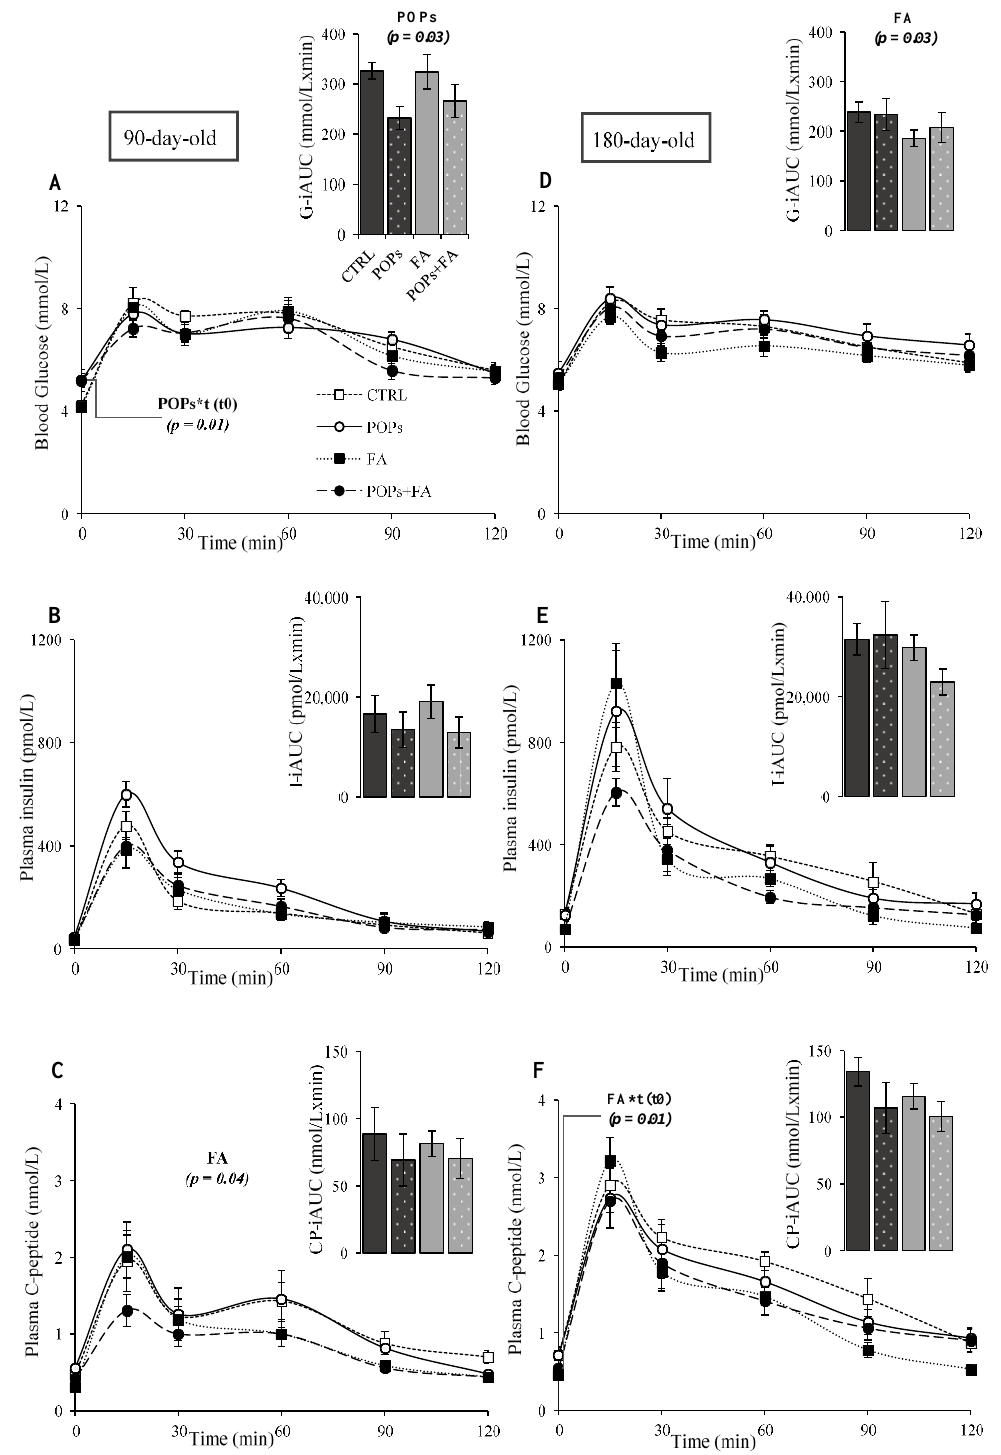
Figure 3. Impact of POP exposure and/or FA supplementation of F0 female rats on blood glucose, plasma insulin and C-peptide during a glucose tolerance test in F1 male rats aged 90 days ( A – C ) and 180 days ( D – F ). The histogram shows incremental area under the curve (IAUC) values. Results are expressed as mean ± SEM (n = 7 to 10). Two-way ANOVA with repeated measurements was used to compare time points within groups. ANOVA for a 2 × 2 factorial experiment was used to analyze the POP and FA main effects and the POPs*FA interaction.